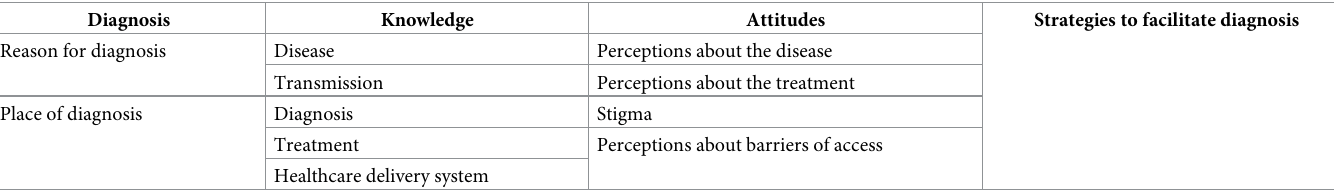
Table 1. Categories and codes established in the